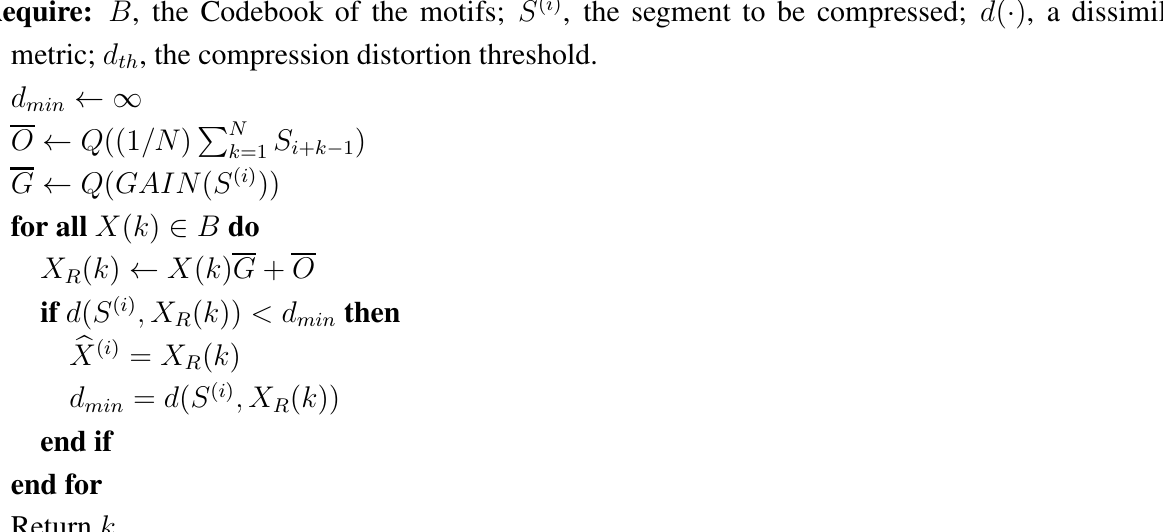
Algorithm 2 Motif selection